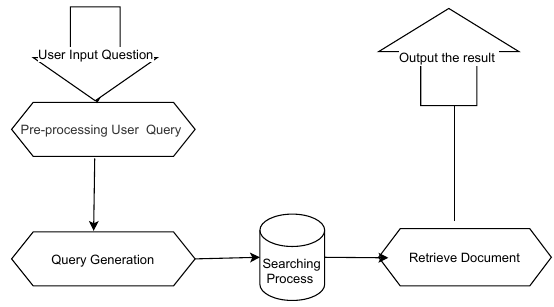
Figure 4. General architecture of QAS.